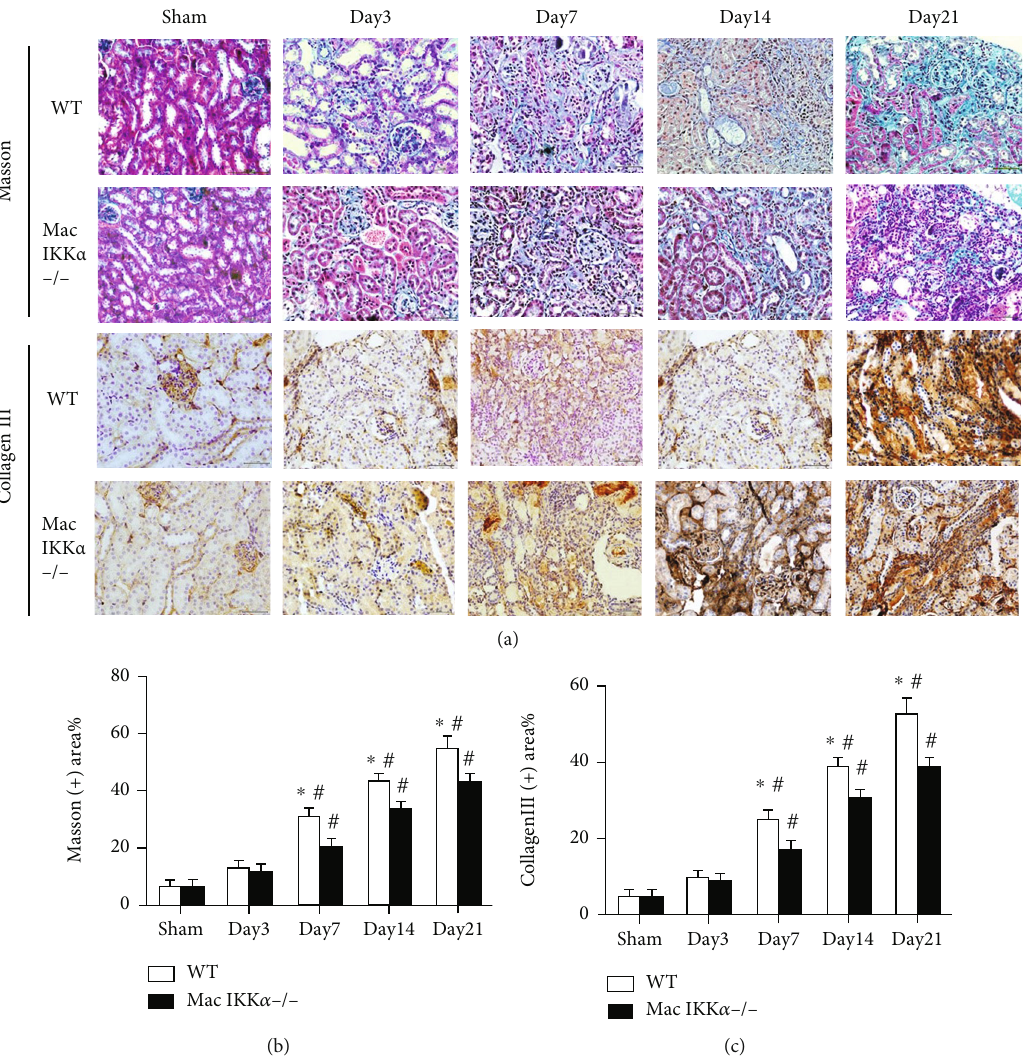
Figure 4: Renal pathological changes in fi brosis. (a, b) Representative images of Masson trichrome staining in kidney sections from sham- treated and IRI mice at the indicated time points. The fi brotic areas increased as time passed, and the extent of fi brosis in WT mice was greater than in Mac IKK α − / − mice after day 7 following IRI. Scale bar = 50 μ m ; magni fi cation, × 400. (a, c) Representative images of immunohistochemical staining of kidney sections for collagen III. The analysis of the images was consistent with Masson trichrome staining. Data are presented as the mean ± s : d . ∗ P < 0 : 05 versus Mac IKK α − / − mice; # P < 0 : 05 versus sham-treated mice of the same genotype; n = 4 -6, two-way